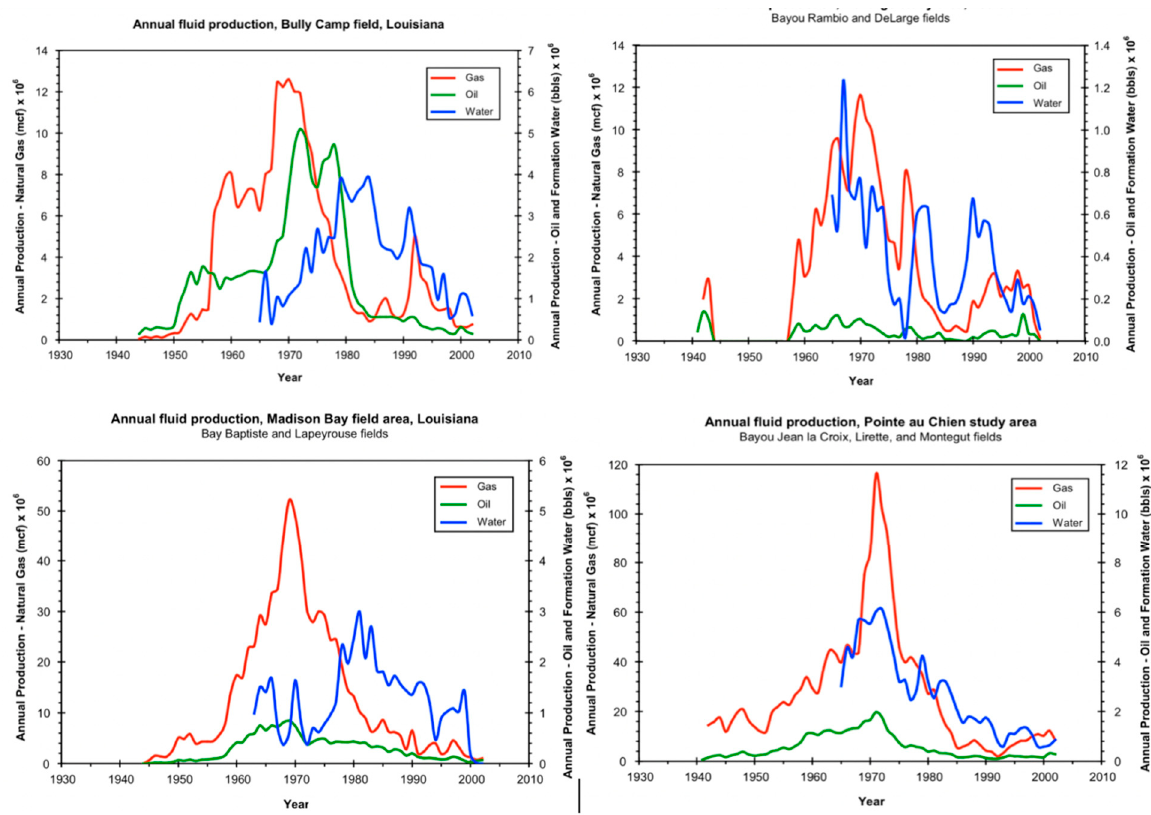
Figure 5. Production history of selected oil and gas fields in the Mississippi delta. Upper left—Bully Camp; upper right—Bayou Rambio and DeLarge fields; lower left—Madison Bay field area; lower right—Pointe au Chien study area [30]. Note that “water” in the legends refers to produced water.